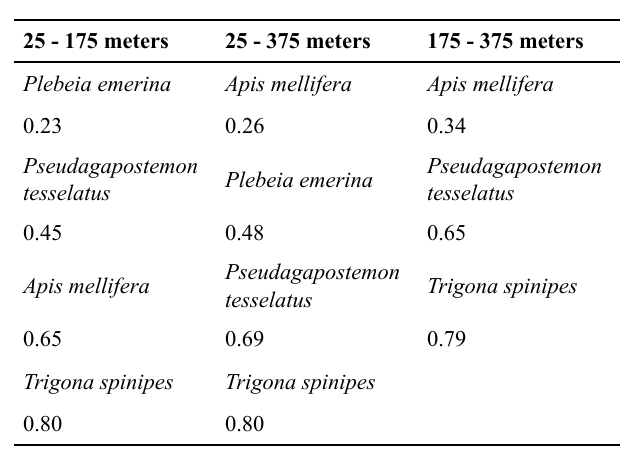
Table 1 . Cumulative contributions of most influential species to the differentiate set of distances from forest fragments around canola ( Brassica napus ) fields in Southern Brazil .